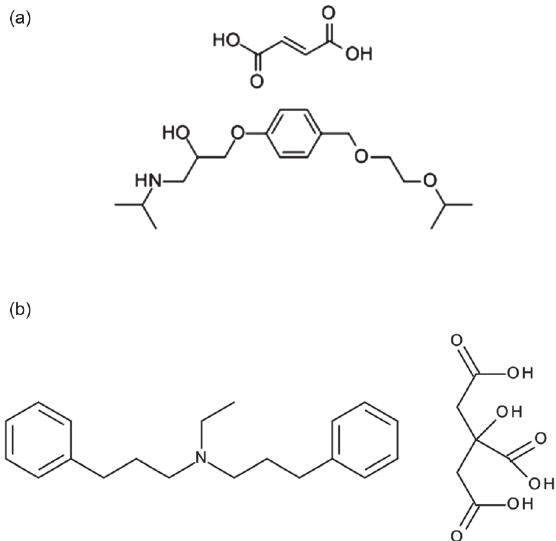
Figure 1: Chemical structure of (a) bisoprolol fumarate and (b) alverine